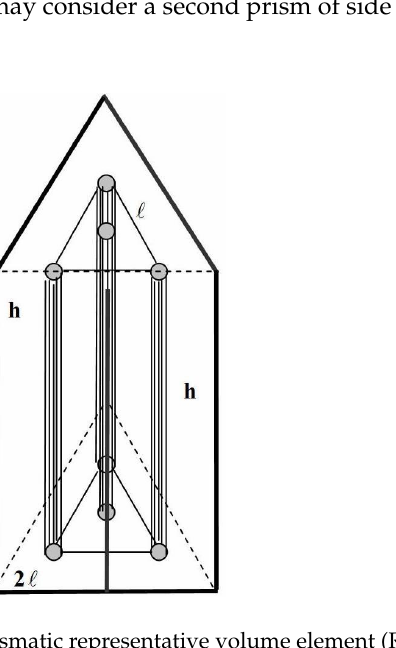
Figure 3. Four-phase coaxial cylindrical model.